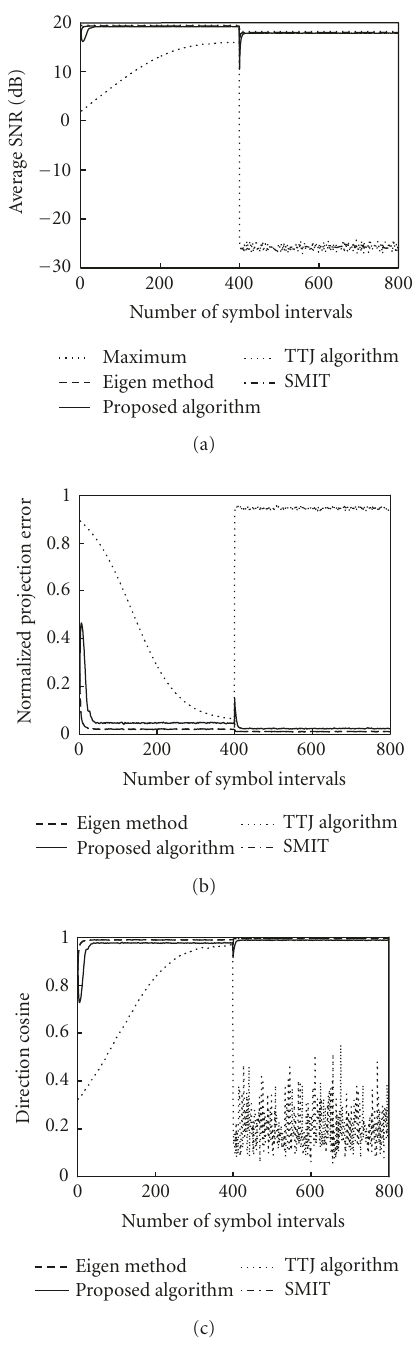
Figure 3: (a) SINR performance in the dynamical signal environ- ment. (b) Normalized projection error in the dynamical signal envi- ronment. (c) Direction cosine performance in the dynamical signal